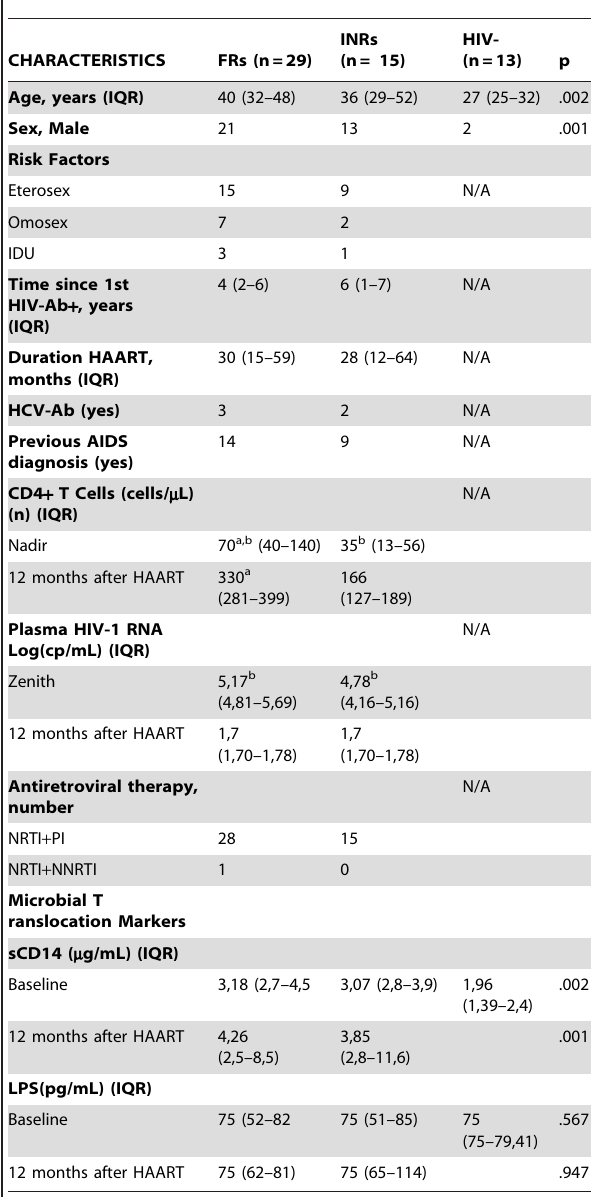
Table 1. Patients’